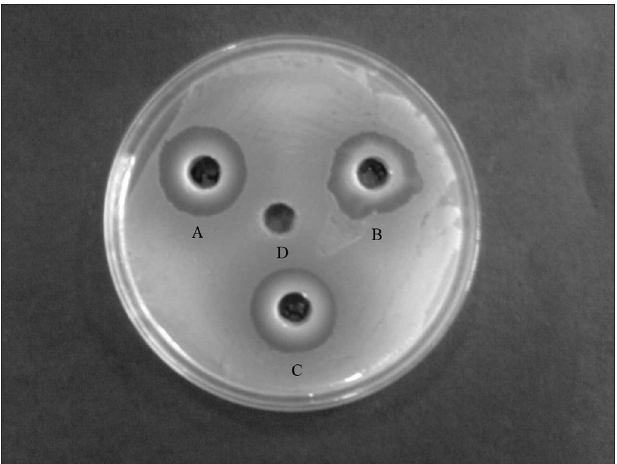
Figura 1. Zona de inibição antibacteriana de extratos orgânicos das folhas da T. arjuna contra S. aureus por extratos acetônicos (A),